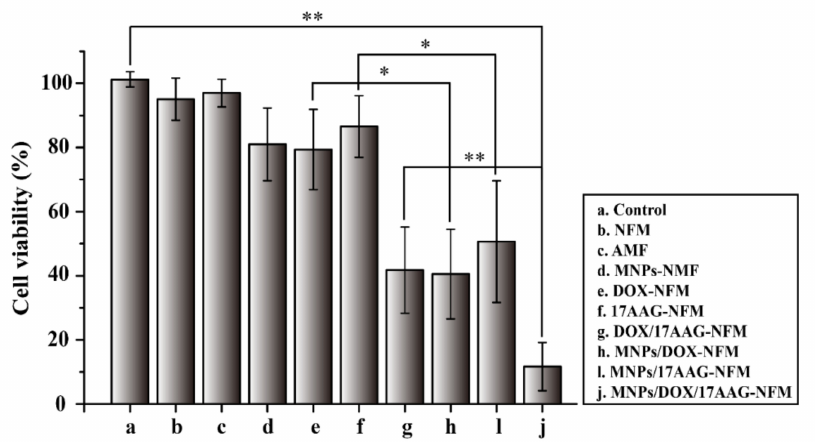
Figure 5. Viability of MCF-7 cells treated with PCL-based nanofiber meshes under AMF irradiation. (Data are mean ± SD, n = 6, ** p < 0.01 * p <